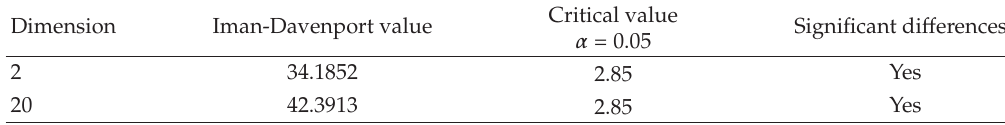
Table 5: Results of the Iman-Davenport